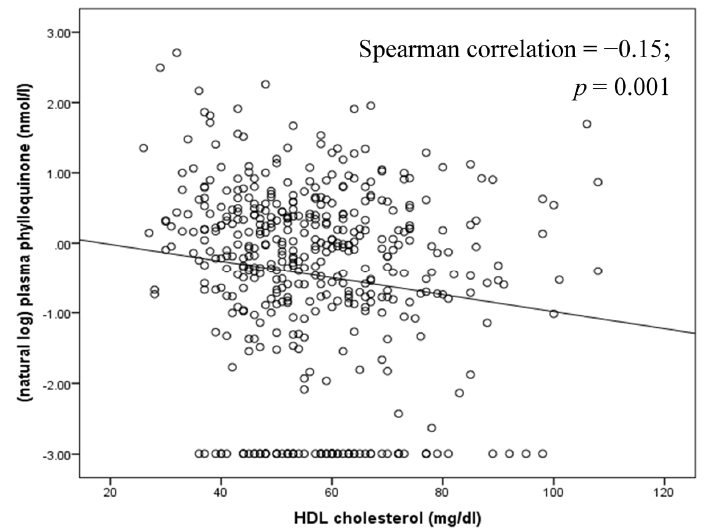
Figure 3. Correlation between circulating phylloquinone and lipids at baseline in community-dwelling older men and women participating in a phylloquinone supplementation trial [39,40].